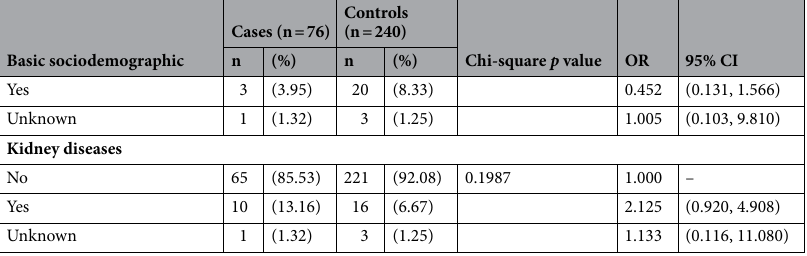
Table 1. Distribution of basic characteristics between participants with sarcopenia and